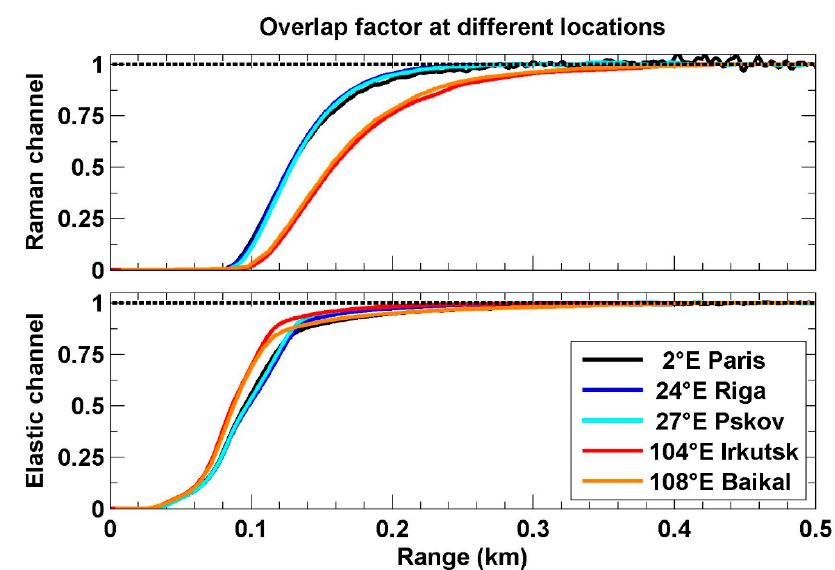
Figure 3. Overlap factors of the: lidar elastic and perpendicular polarization channels ( bottom ); and N 2 -Raman channel ( top ), as experimentally measured using horizontal shooting before departure (black line) and vertical shooting along the journey (blue, cyan, red and orange lines for Riga, Pskov, Irkutsk and Lake Baikal positions, respectively).